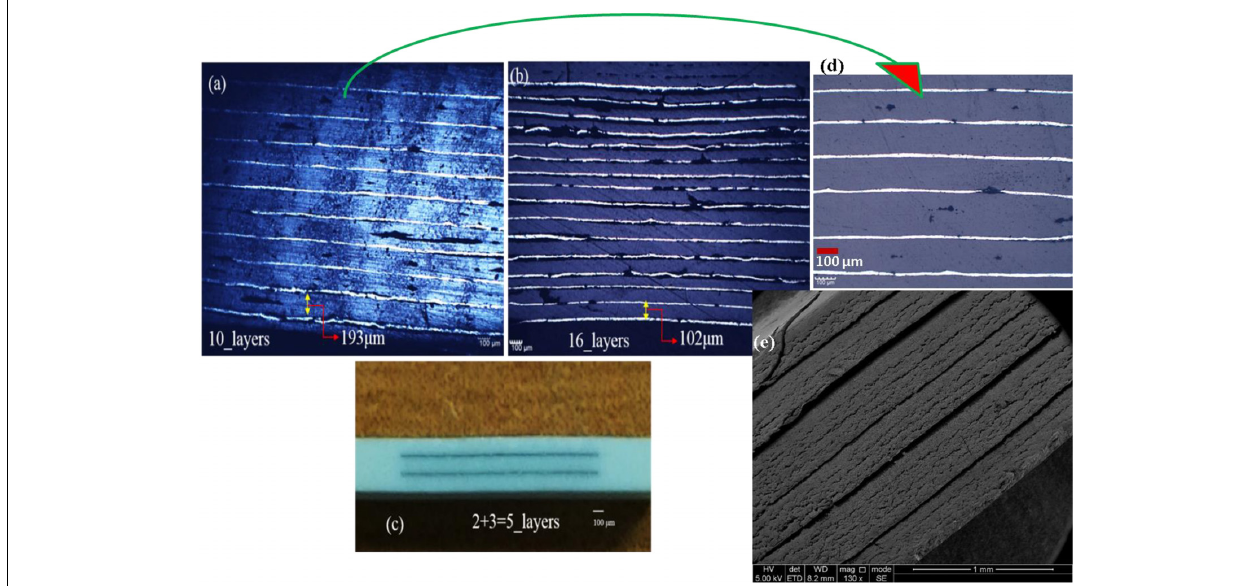
FIGURE 3 | Optical Microscopic viewing cross-sectional images of middle-sectioned sample to show all inner electrodes of (a) 10_layers and (b) 16_layers MLA (0.942KNN_50/50-0.58BNZ); (c) Optical photograph of 5_layers KNN_51/49 showing two alternate layers of inner electrode of one side cross section, (d) zooming of 10-layers sample, and (e) SEM image (130X) showing severe delamination in conventionally prepared MLAs.